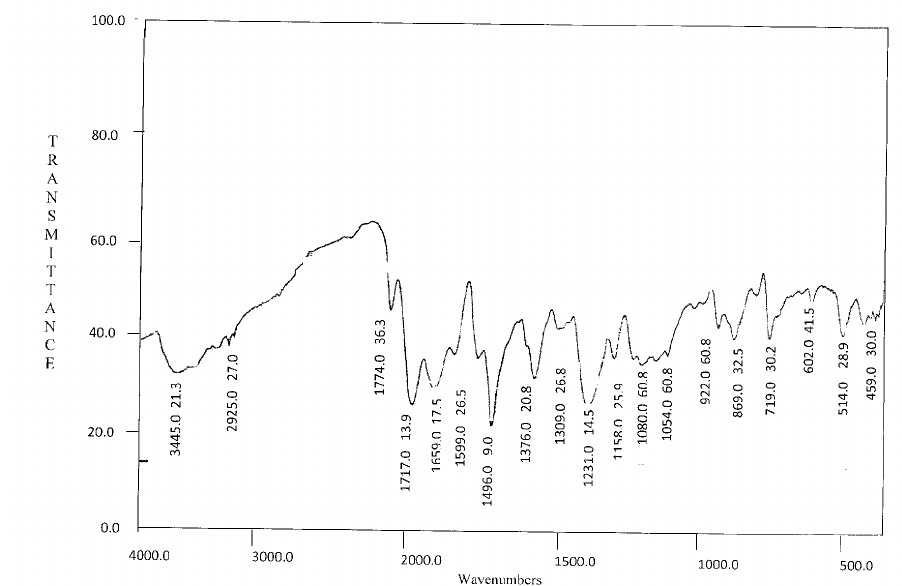
Figure 4. FT-IR spectrum of PAI-nanocomposite films 4a.